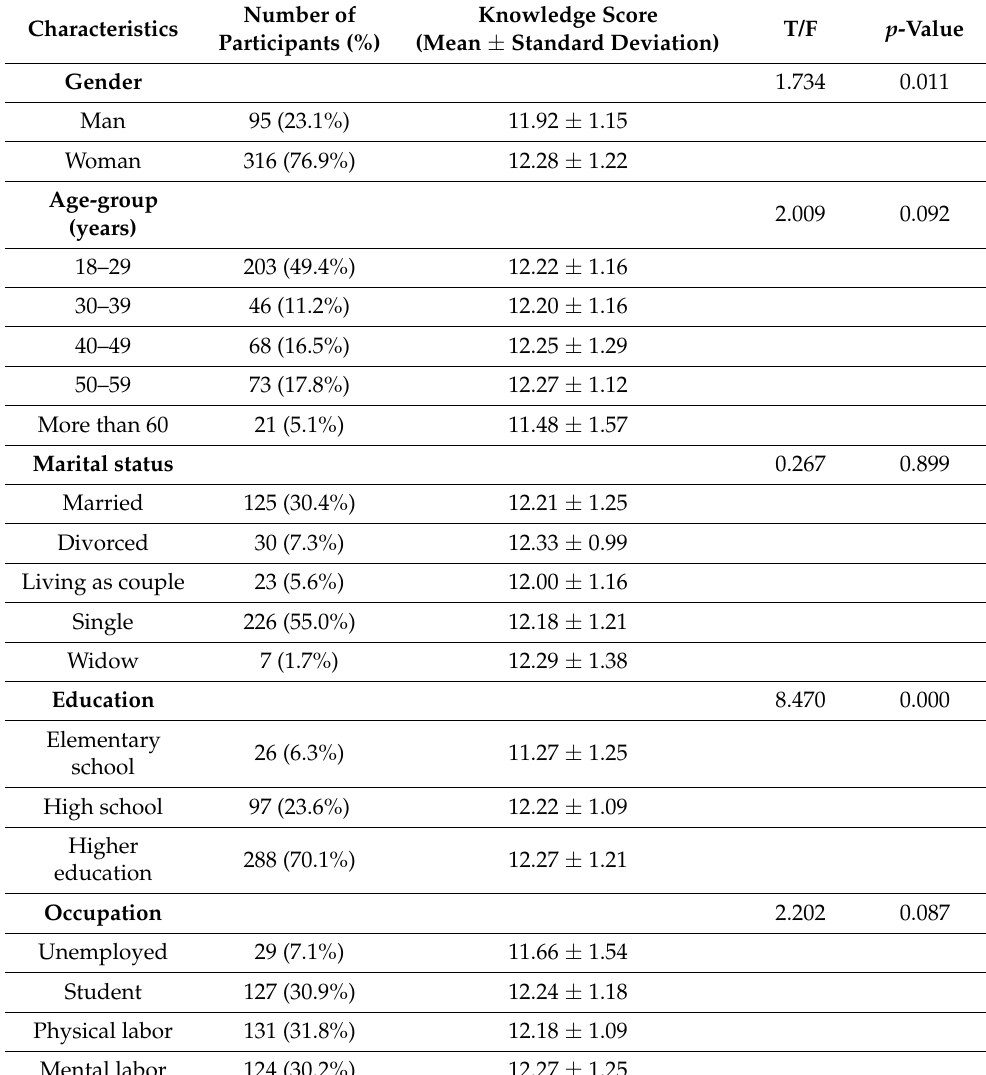
Table 4. Demographic characteristics of participants and COVID-19 knowledge score by demo- graphic